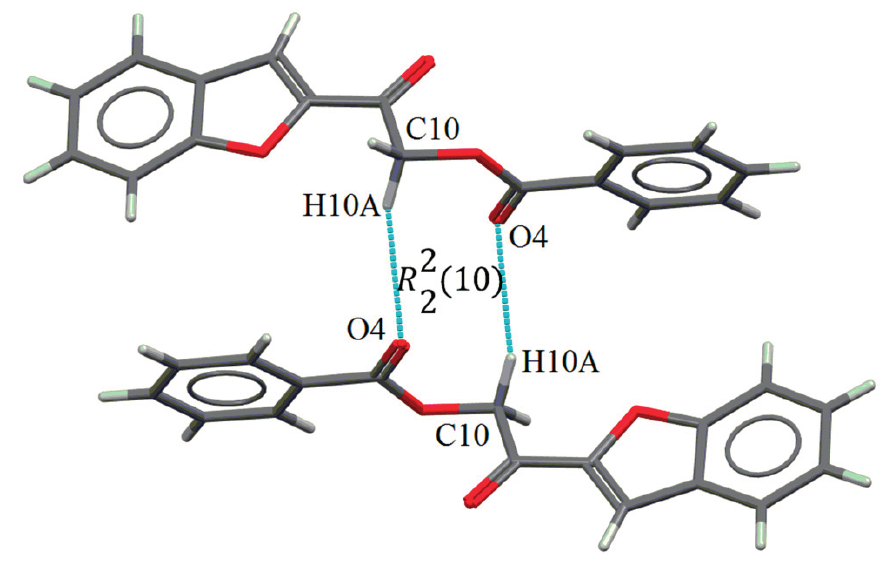
Figure 4. Intermolecular C–H···O hydrogen bonds (blue color) form dimeric structures in 4a .